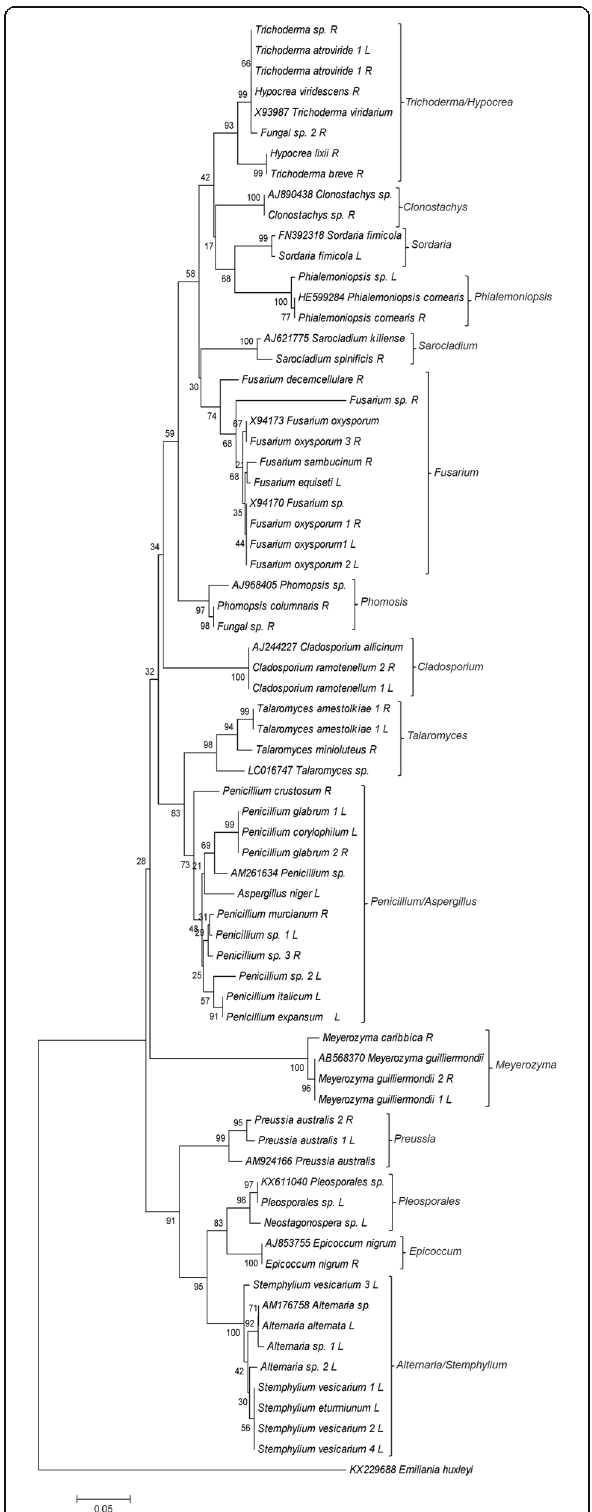
Fig. 1 Neighbor Joining (NJ) tree showed phylogenetic relationship between 64 sequences of endophytic fungi from root (R) and leaves (L), based on the ITS rDNA sequences. NCBI sequences were added for showing clades. Bootstrap 1000, values are shown at the branch